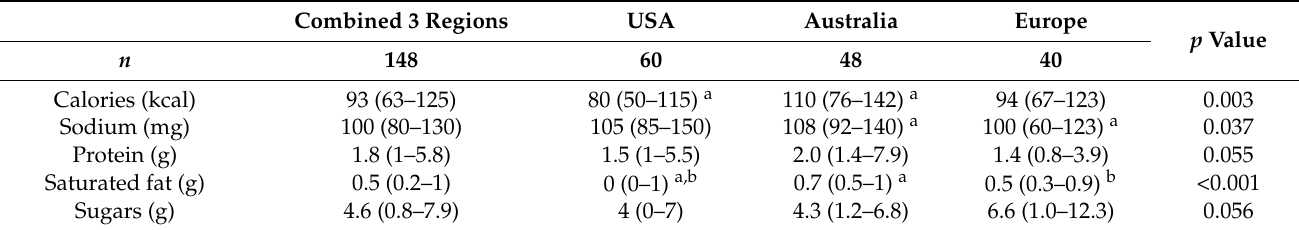
Table 3. Median (Q1–Q3) values of calories and selected nutrients in non-dairy beverages per serving, by